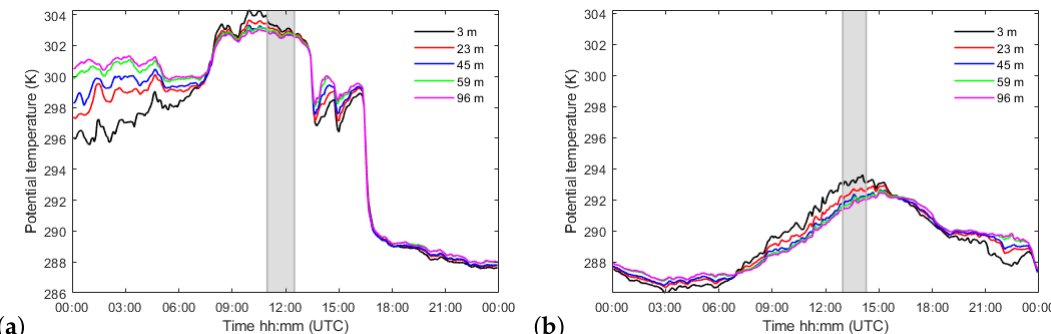
Figure 12. Time series of 10-min averages of potential temperature on 21 ( a ) and 22 ( b ) September. The grey box marks the time flight periods.